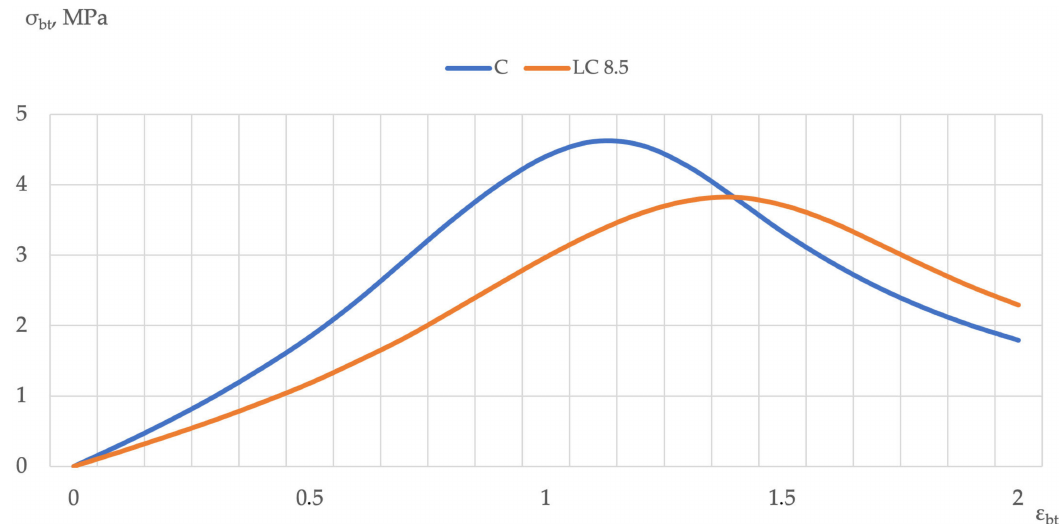
Figure 9. Diagram “stress—strain” in tension for the integral characteristics of vibro-centrifuged concrete (see Figure 8; C—control composition: heavy concrete on non-activated water, LC 8.5—lightweight concrete on activated water with pH =